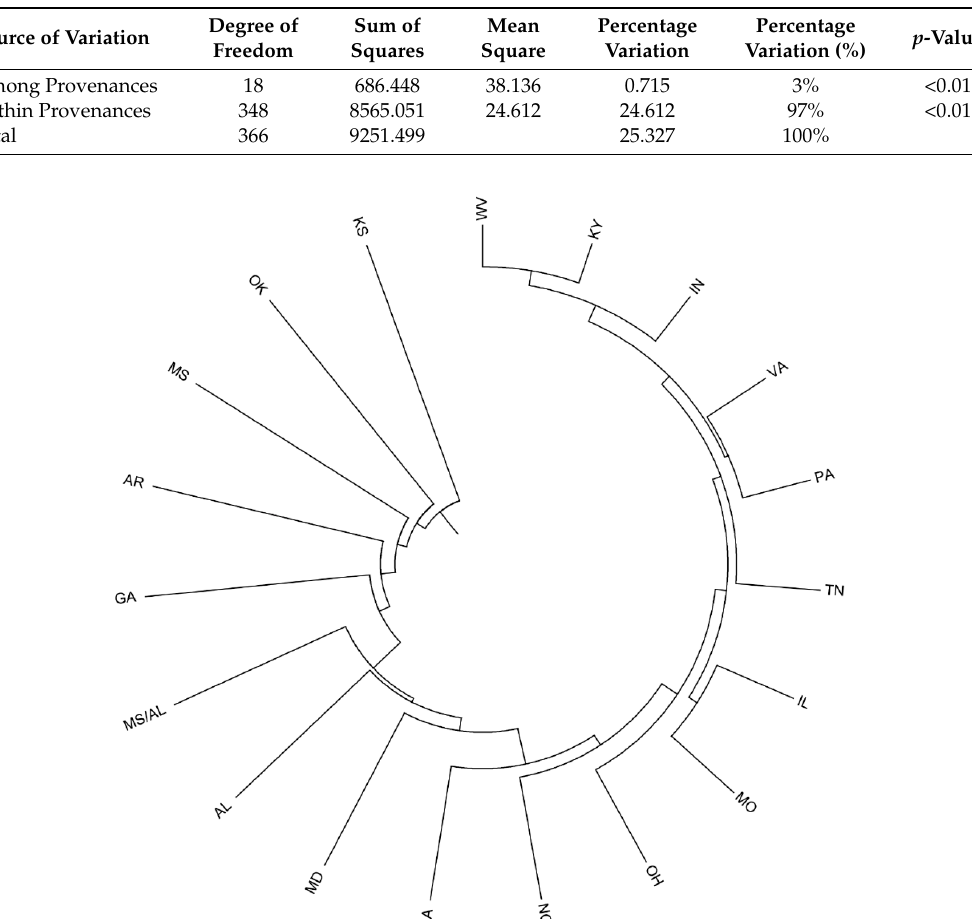
Figure 2. UPGMA dendrogram based on Nei’s (1972) genetic distance values showing the relationship among different provenances of Robinia pseudoacacia L.